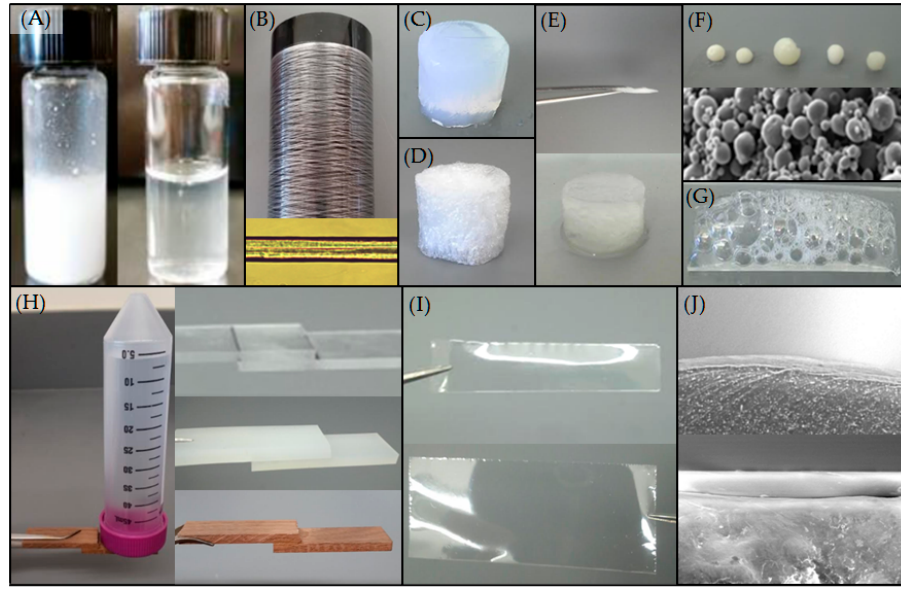
Figure 1. ( A ) Left : Suspension of 3% w / v rMaSp1; Right : Same as left solvated by microwave